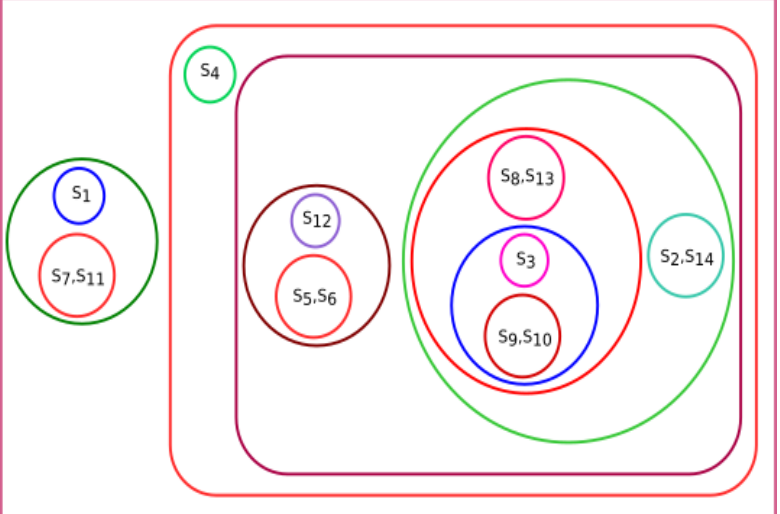
Figure 9. Clusters drawn from Hierarchical clustering phylogenetic trees based on secondary struc- ture. Here, S i represents the species name as specified in Table